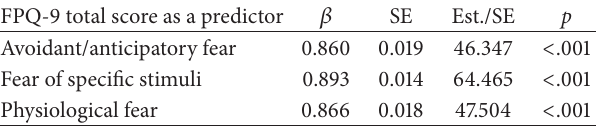
Table 3: Relationships between FPQ-9 total scores and the three DFS